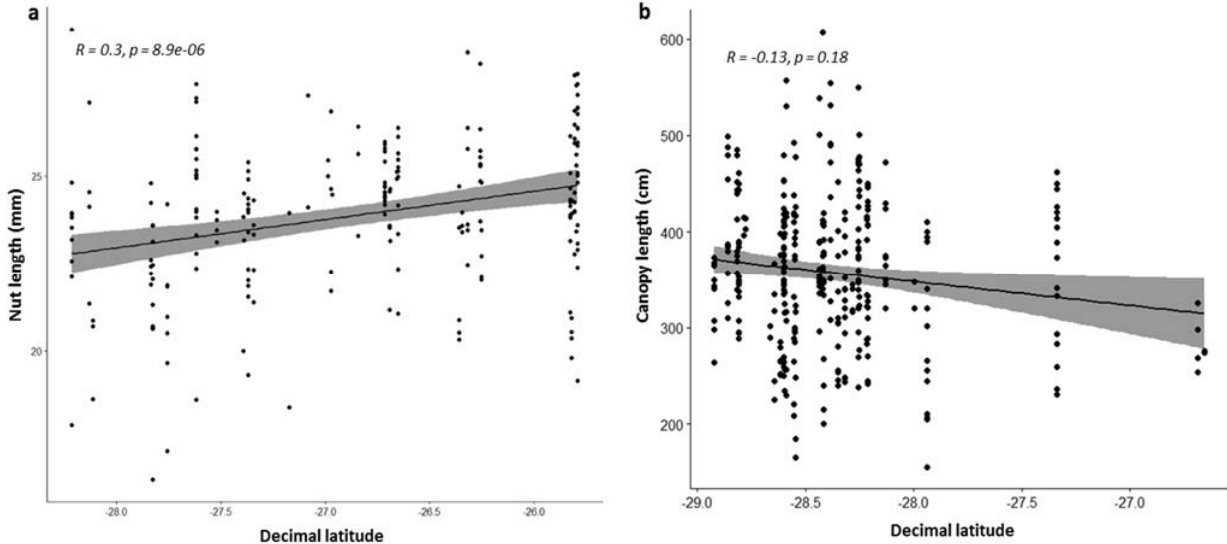
Figure 2. Plots of predicted accession values for ( a ) nut length in M. integrifolia and ( b ) canopy length in M. tetraphylla by latitude of collection origin. Each point denotes one accession. The solid black line indicates the linear regression, and the grey shaded area represents the 95% confidence